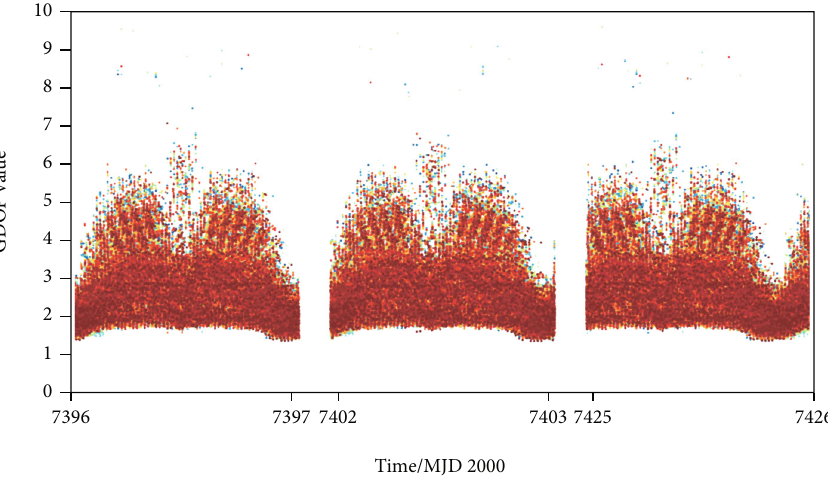
Figure 9: Navigation performance of the 77-satellite Walker